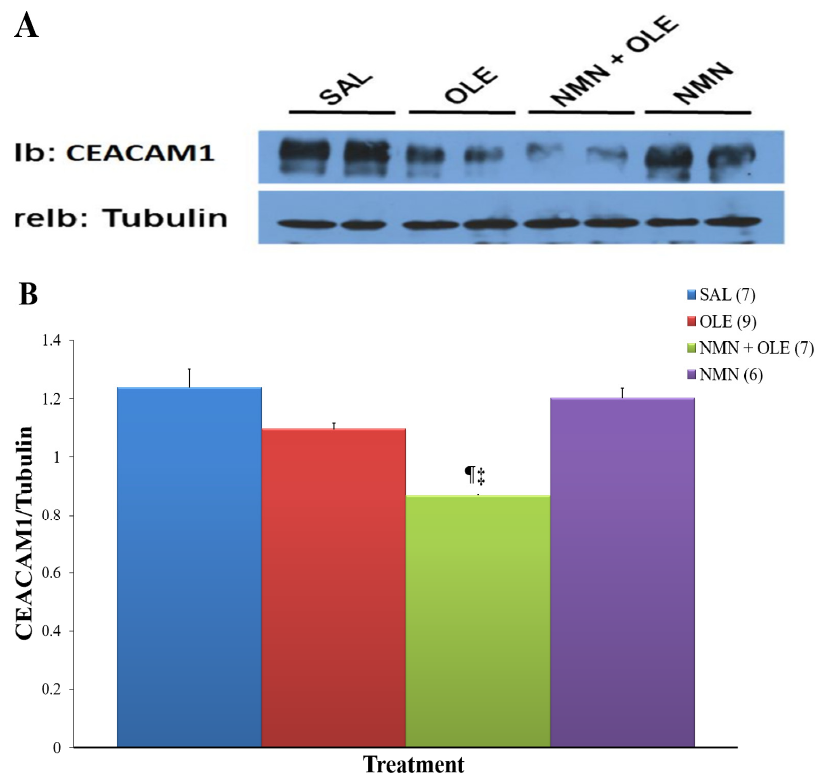
Figure 3. Western Blot analysis of hepatic CEACAM1 protein levels. Mice were infused for 48 h with SAL, OLE, NMN + OLE, or NMN before livers were extracted and 7 μ g of protein lysates were analyzed by 7% SDS-PAGE followed by immunoblotting (Ib) the upper half of the membrane with a polyclonal antibody against α -CEACAM1 (1:500, Ab-2457) and the lower half with a monoclonal antibody against Tubulin (as a loading control). ( A ) A representative blot is shown. ( B ) Protein band density was quantified using Image J. Data are means ± SE. Number in parentheses represents number of animals. ¶ p < 0.05, SAL vs. NMN + OLE; ‡ p < 0.05, NMN + OLE vs. NMN. Table 1. Effect of adenovirus-mediated overexpression of: ( A ) SIRT1 ( B ) SIRT2 and ( C ) SIRT inhibitor sirtinol on hepatic CEACAM1 mRNA levels in HepG2 cells. mRNA levels were assessed in triplicate/transfection and normalized to human Gapdh gene. Data are means ± SE. * p < 0.05 and ** p <